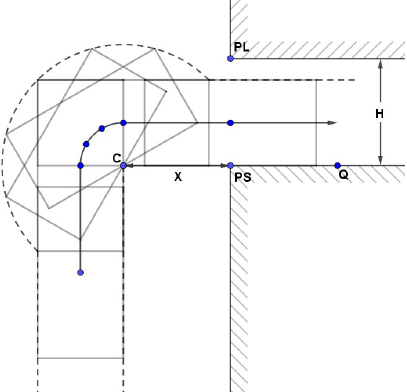
Figure 6. The illustration of the theoretical path computation model for an RRB.